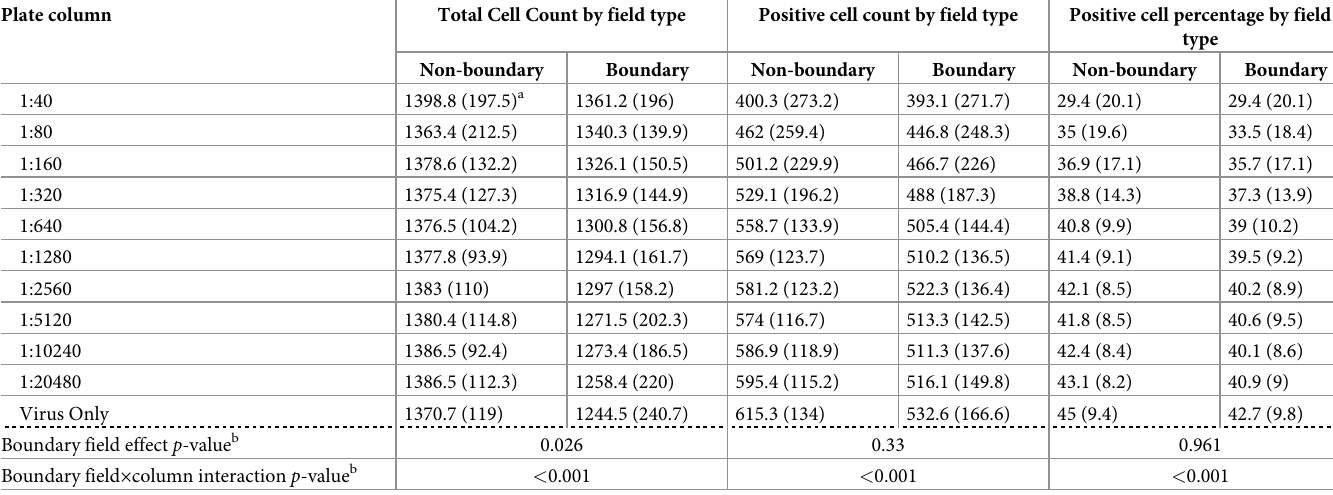
Table 1. Comparison of total cell count, positive cell count and positive cell percentage between boundary fields and non-boundary fields by plate column.